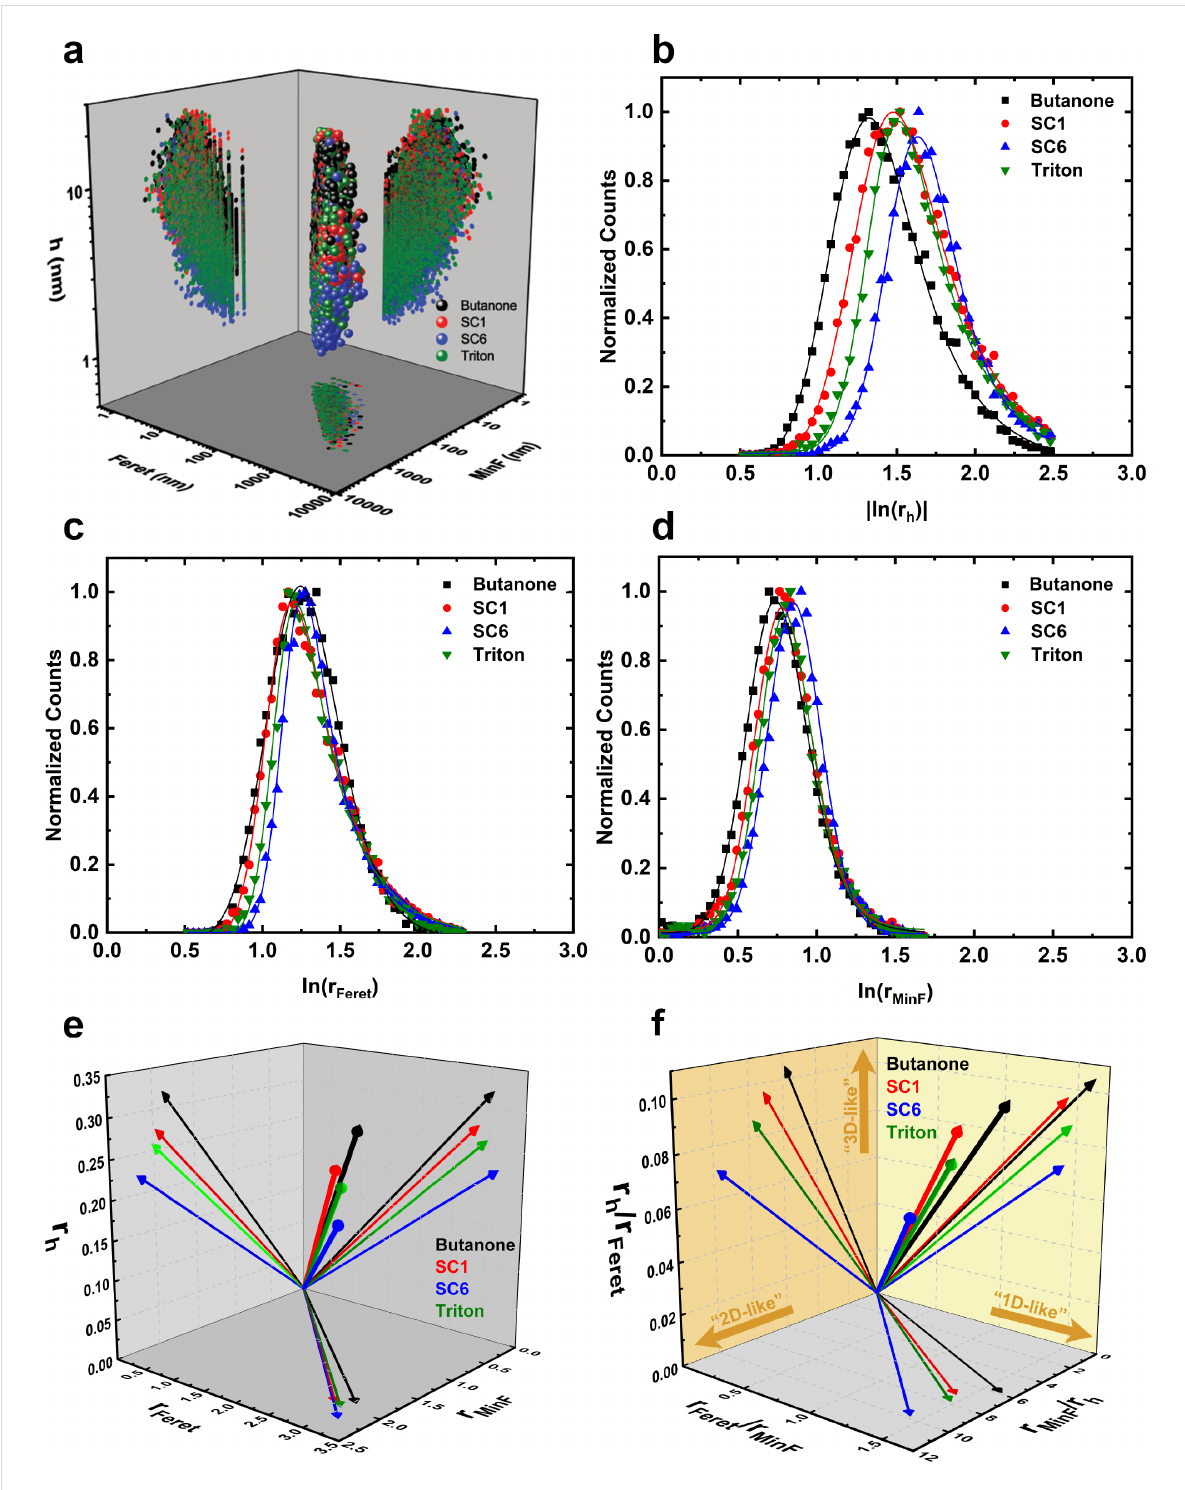
Figure 3: Characteristic lengths, normalized probability distributions, and topological vectors of the dimensionless aspect ratios r h , r Feret , and r MinF for talc flakes obtained via LPE in four different media. (a) 3D plot of average height and maximum and minimum Feret diameters for all flakes of the four samples. (b–d) Normalized distributions of ln( r h ), ln( r Feret ) and ln( r MinF ), respectively, for each sample (black squares: butanone; red circles: sodium cholate at 1 mg/mL; blue upward triangles: sodium cholate at 6 mg/mL; green downward triangles: Triton-X100). For r h , the absolute value of the loga- rithm was plotted to avoid negative values and facilitate comparison with the other parameters. (e) Three-dimensional topological vector representa- tion of r h , r Feret , and r MinF for all samples. (f) Topological vectors of three pairwise ratio combinations of r h , r Feret , and r MinF